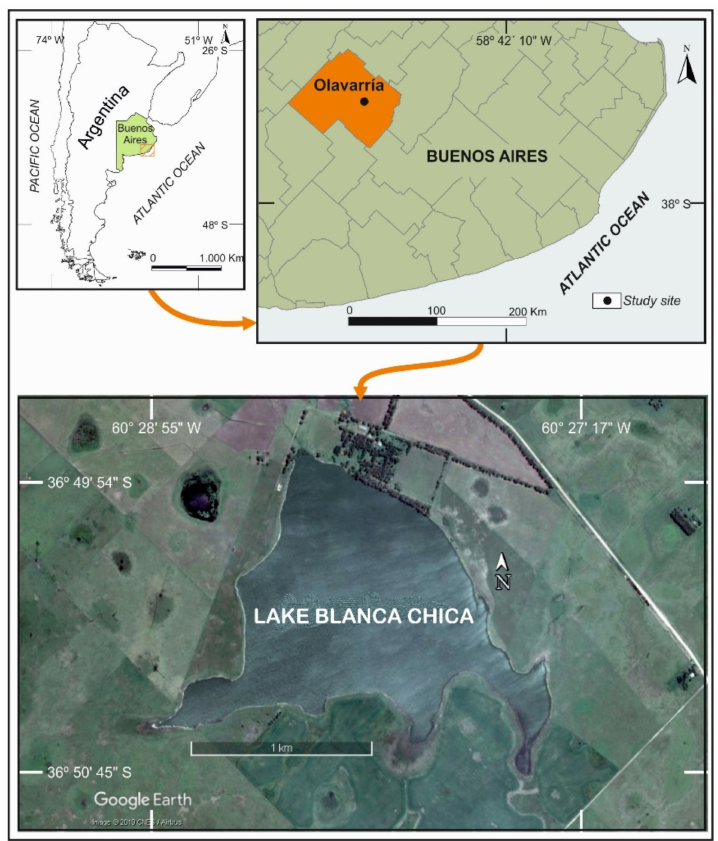
Figure 1. Location of Lake Blanca Chica in the the Argentinean Pampa Plain, South